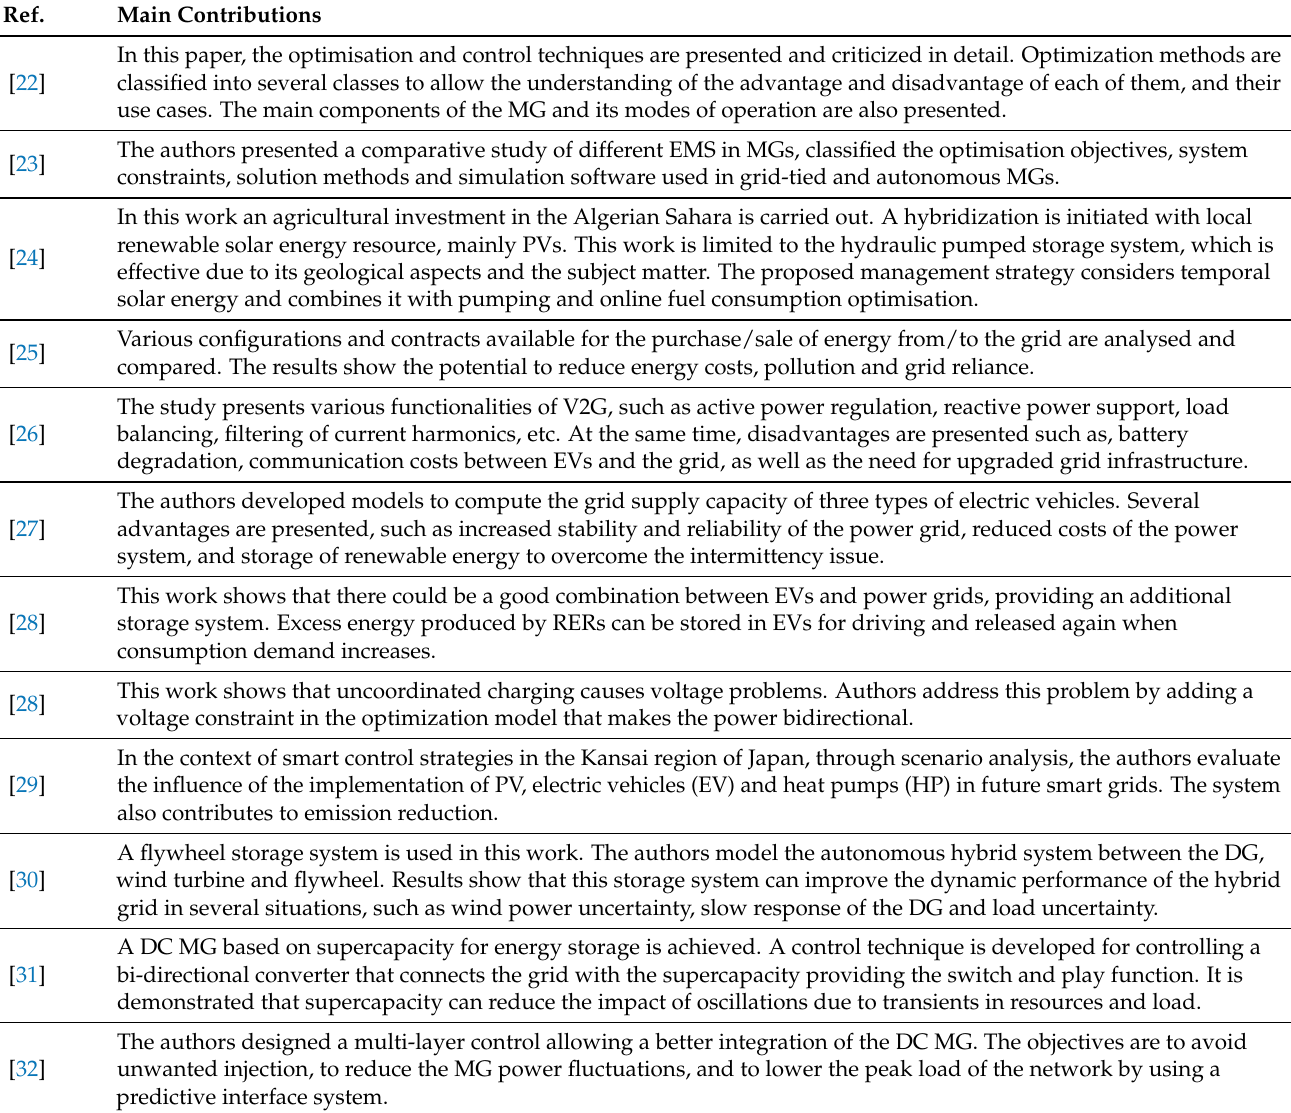
Table 1. Main papers about energy management systems of